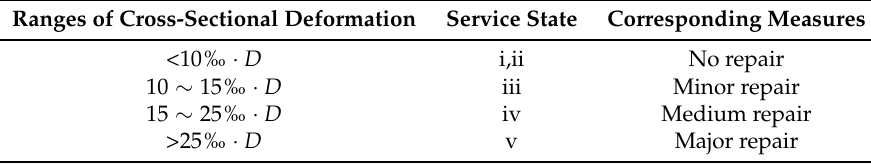
Table 3. Assessment of the service state of the shield tunnel.